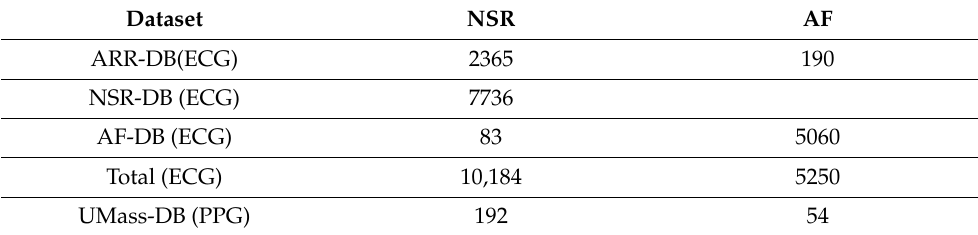
Table 3. Total data Samples of NSR and AF classes after